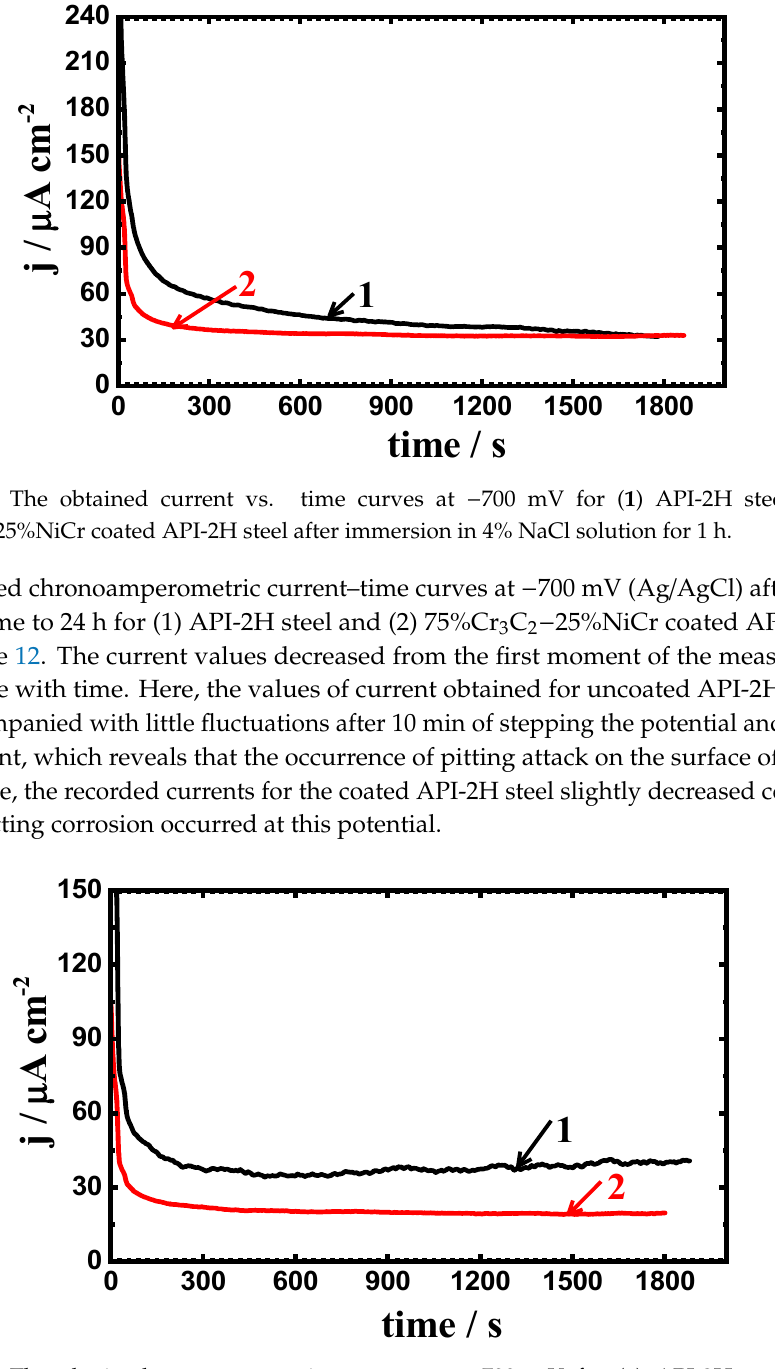
Figure 12. The obtained current vs. time curves at − 700 mV for ( 1 ) API-2H steel and ( 2 ) 75%Cr 3 C 2 − 25%NiCr coated API-2H steel after immersion in 4% NaCl solution for 24 h.